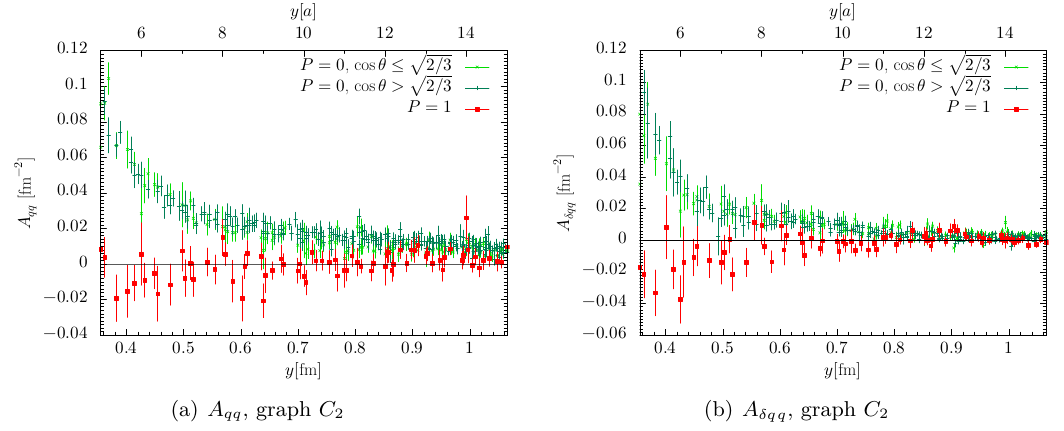
Figure 8 . Twist-two functions at intermediate y for graph C 2 . All points are for py = 0 , L = 40 and light